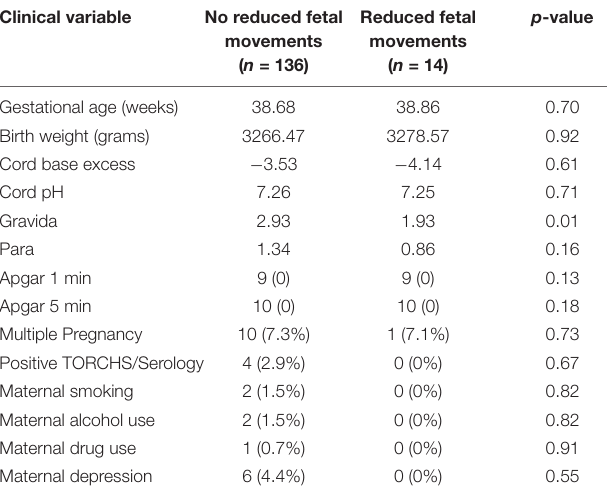
TABLE 5 | Subgroup comparison – babies with and without reduced fetal